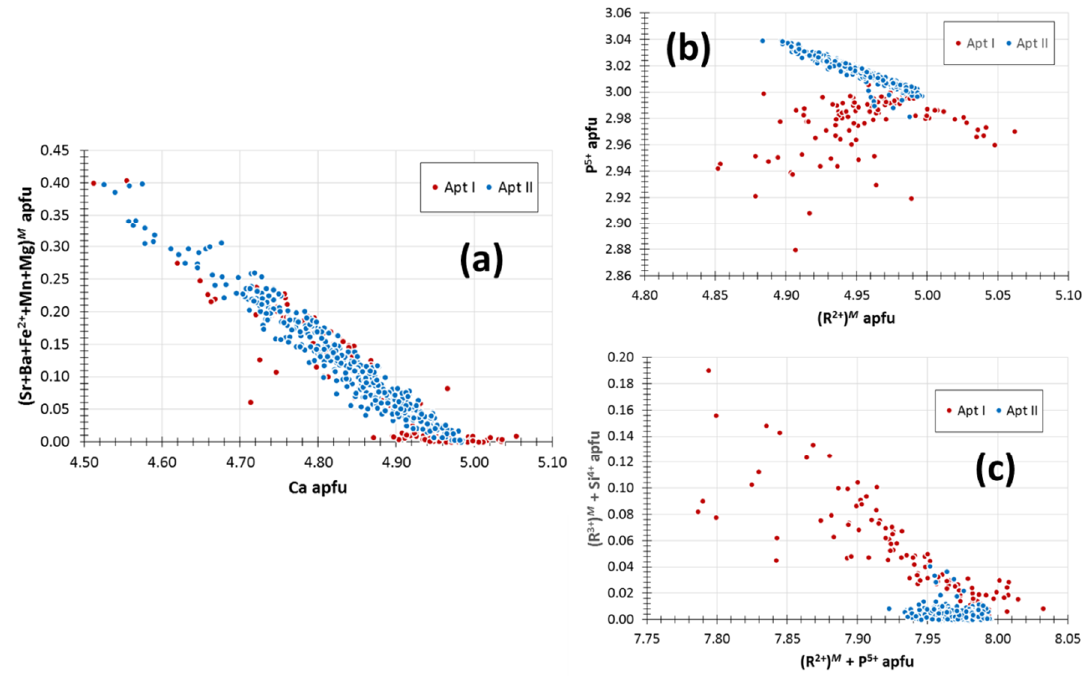
Figure 11. Compositional variations of Apt I and Apt II documenting the usual replacement of Ca by other divalent cations (R 2+ = Sr, Ba, Fe 2+ , Mg or Mn), as discussed in text ( a , b ), besides the relative importance of substitutions involving R 3+ (= Fe 3+ + REE) ( c ).